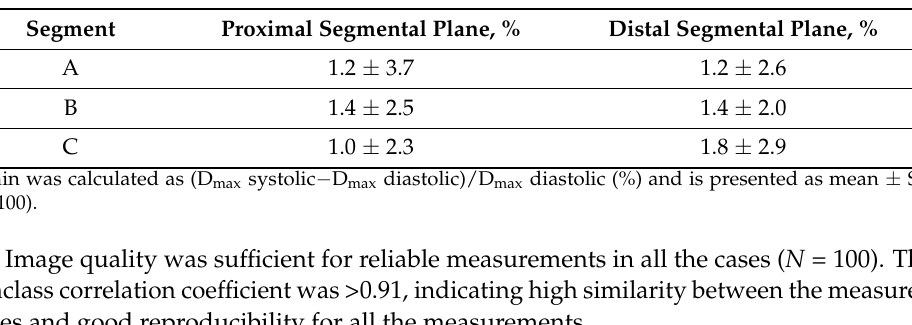
Table 6. Segmental strain of ascending aorta during the cardiac cycle a